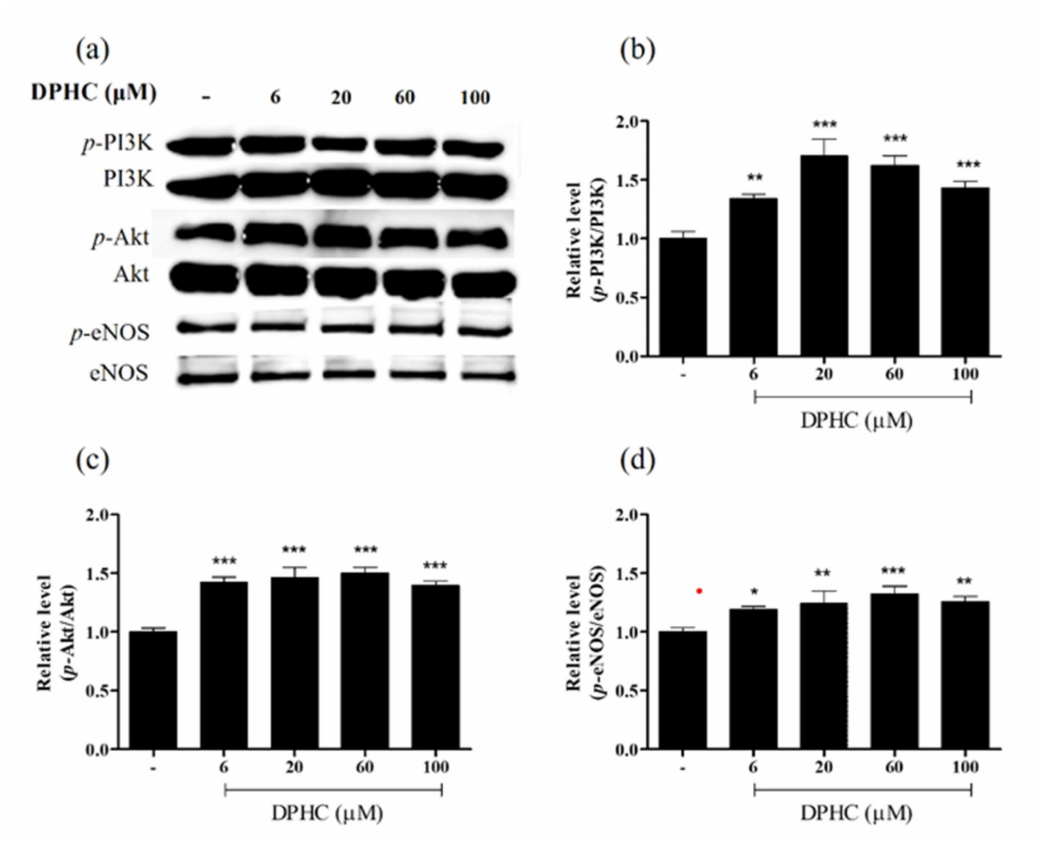
Figure 3. Evaluation of the expression levels of vasodilation-associated proteins. ( a ) Representative Western blot analysis. ( b , c ) Quantification of phosphorylated (p)-PI3K/PI3K ( b ), p-Akt/Akt ( c ), and p-eNOS/eNOS ( d ) in EA.hy926 cells treated with different concentrations of DPHC. The protein bands were ultimately developed and photographed with the FUSION Solo Vilber Lourmat system. Quantitative data were analyzed using Image J 1.50i software (NIH, USA). Results are expressed as the mean ± standard deviation (S.D.) of three independent experiments. * p < 0.05, ** p < 0.01. *** p < 0.001, significant difference compared to the control group. DPHC: diphlorethohydroxycarmalol; PI3K: phosphoinositide 3-kinase; Akt: protein kinase B; eNOS: endothelial nitric oxide